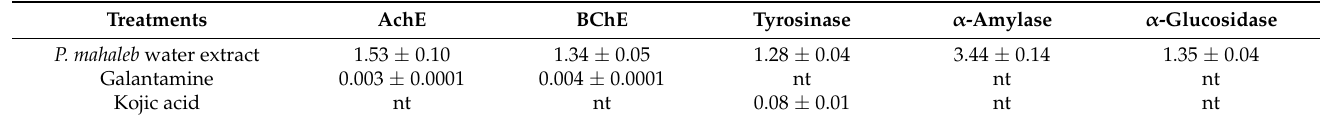
Table 2. Enzyme inhibition